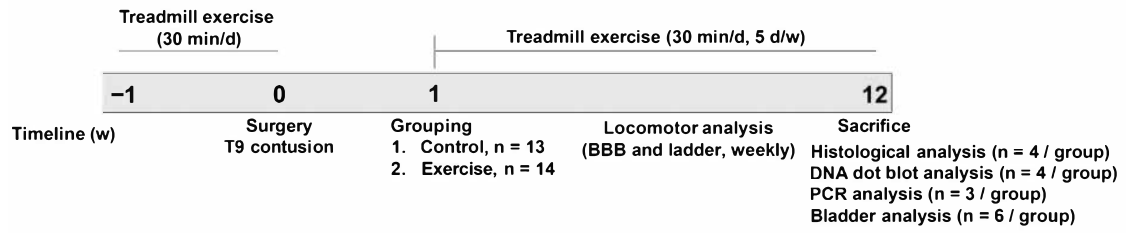
Figure 1. Timeline of the